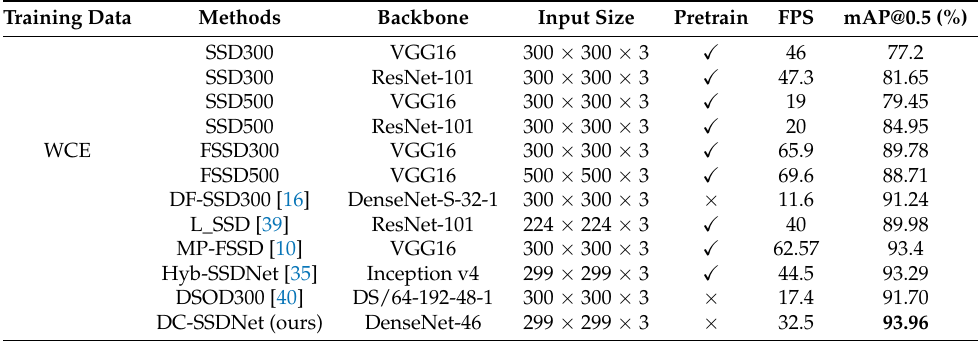
Table 4. SSD comparison with previously reported approaches based on the WCE test set. Pretrain denotes a pretrained backbone to initialize the model, as opposed to starting from scratch. The Google Colab pro+ GPU was used to assess the speed (FPS) and performance (mAP). Training Data